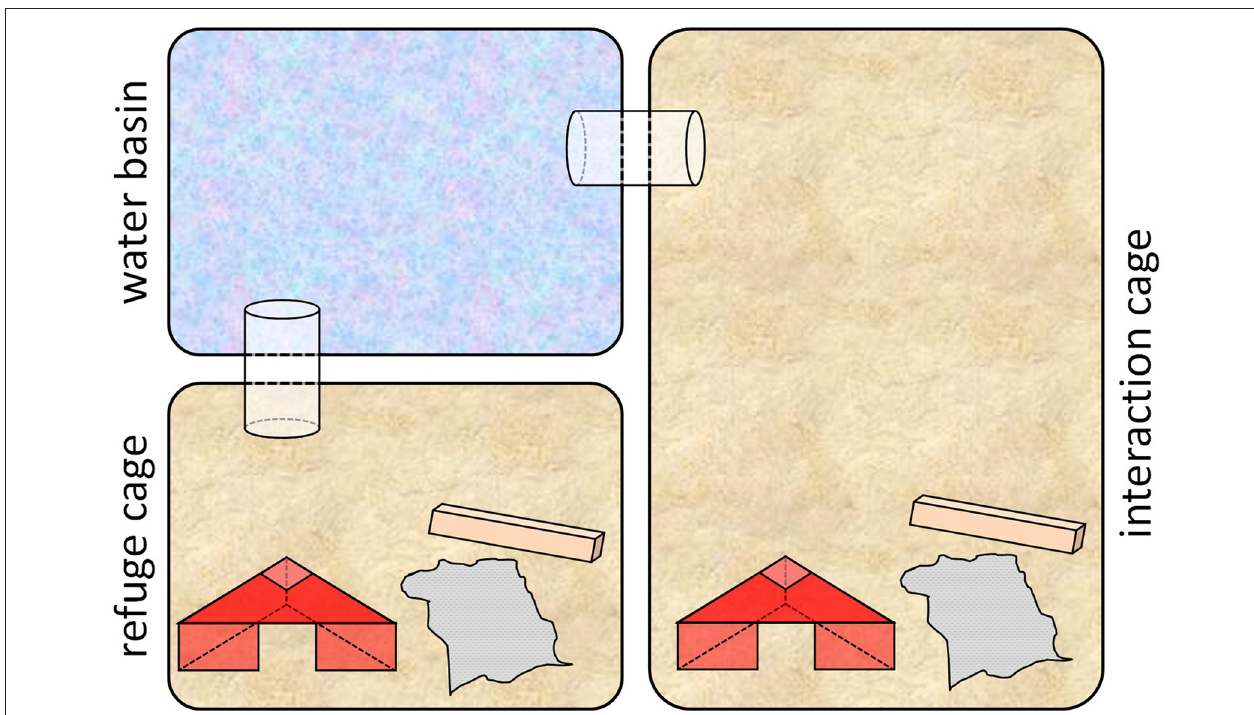
FIGURE 2 | Cage system used in phase 2. The custom-made cage systems comprised an interaction cage (Makrolon type III with bedding and enrichment), a refuge cage (Makrolon type II with bedding and enrichment) and a water basin (Makrolon type II, filled with water to a height of approximately 3 cm; Figure modified after Meyer et al.,